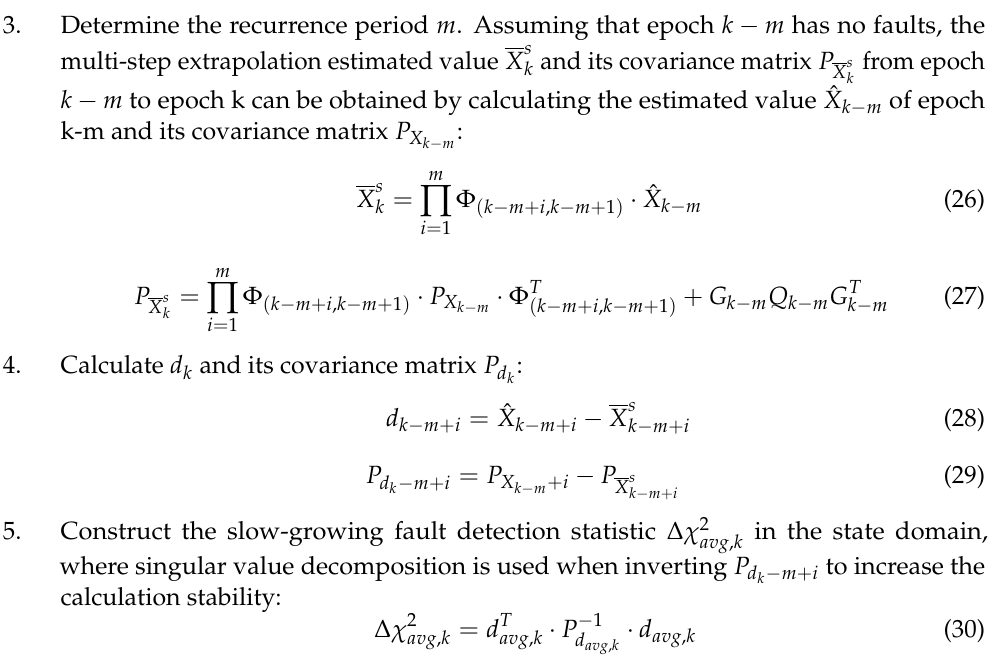
in the state domain, avg , k to increase the k − m + i